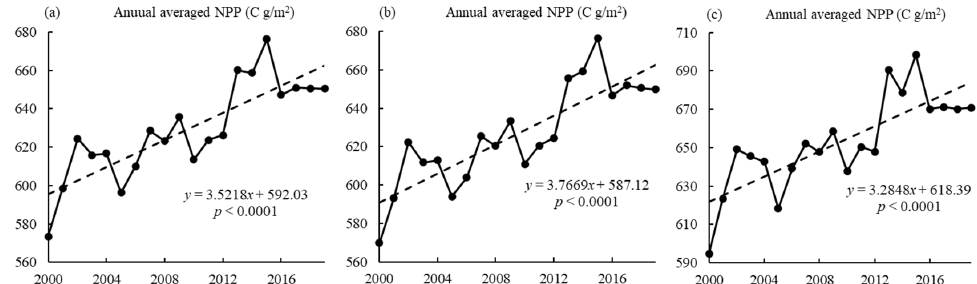
in YRB. The annual average NPP of the two kinds of forest showed a significantly increas- ing trend ( p < 0.0001). However, in 2016–2019, the NPP value changed very little. Besides, the annual average NPP of F old was higher than that of F new because of the less disturbance distributed in Sichuan and Yunnan (>800 g C m − 2 year − 1 , Figure 4). Conversely, the lower NPP to F old . However, the significant increasing rate of F new was higher than that of F old . The increasing rate of F new and F old was 3.77 g C m − 2 year − 1 , 3.28 g C m − 2 year − 1 , respectively. values were in the northwest of the YRB (<200 g C m − 2 year − 1 , Figure 4).